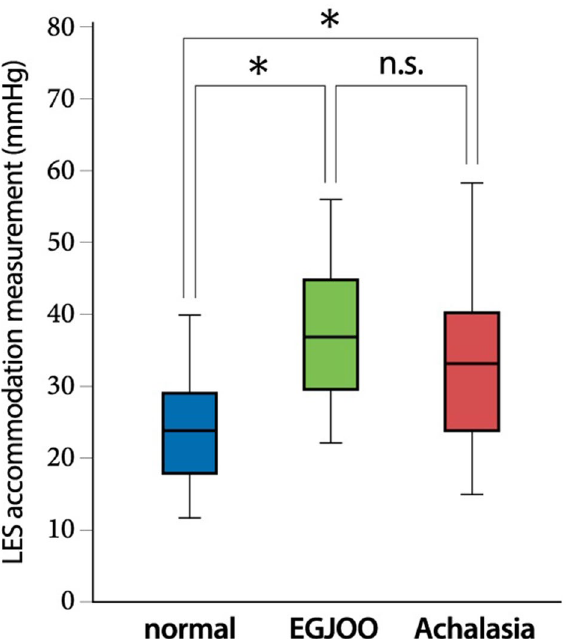
Figure 4. The LES accommodation measurement of the patients with normal HRM, patients with EGJOO and patients with achalasia. A one-way ANOVA followed by Turkey’s multiple comparison test was conducted. *A statistically significant difference between the indicated two groups. n.s., no significant difference between the two indicated